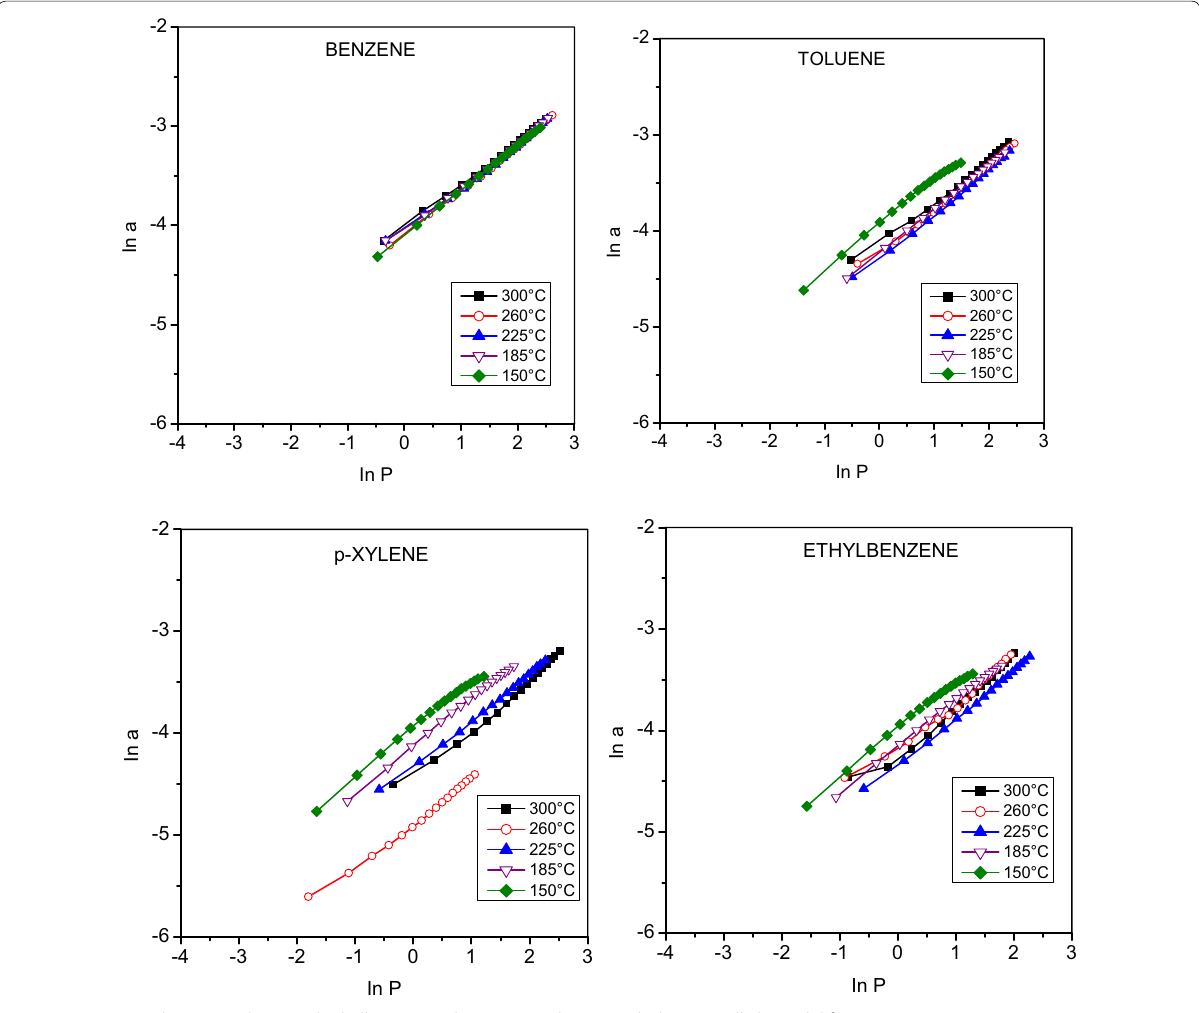
Fig. 7 Benzene, toluene, p ‑xylene, and ethylbenzene adsorption isotherms with the Freundlich model for HT